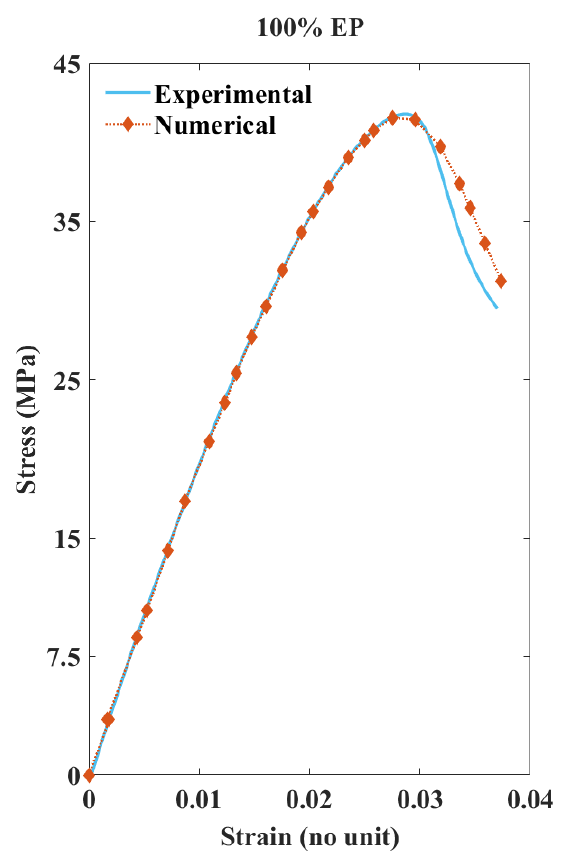
Figure 8. Comparing experimental and numerical SS curves of 100% EP composite.